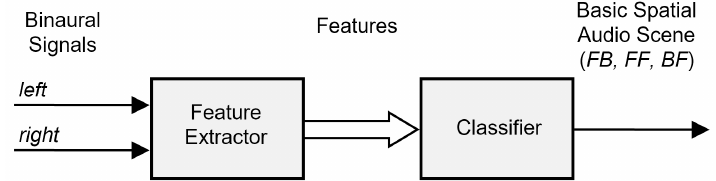
Figure 1. Block diagram of the basic spatial audio scene classifier (output categories are explained in the text). FB : foreground–background; BF : background–foreground; FF : foreground–foreground.